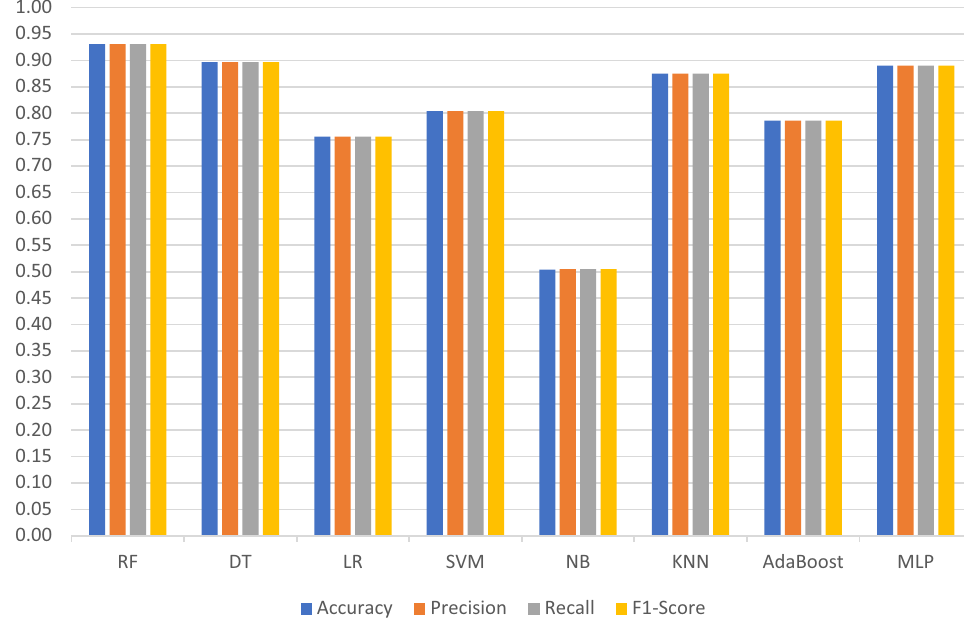
Fig. 4 Results without proposed feature vector generation